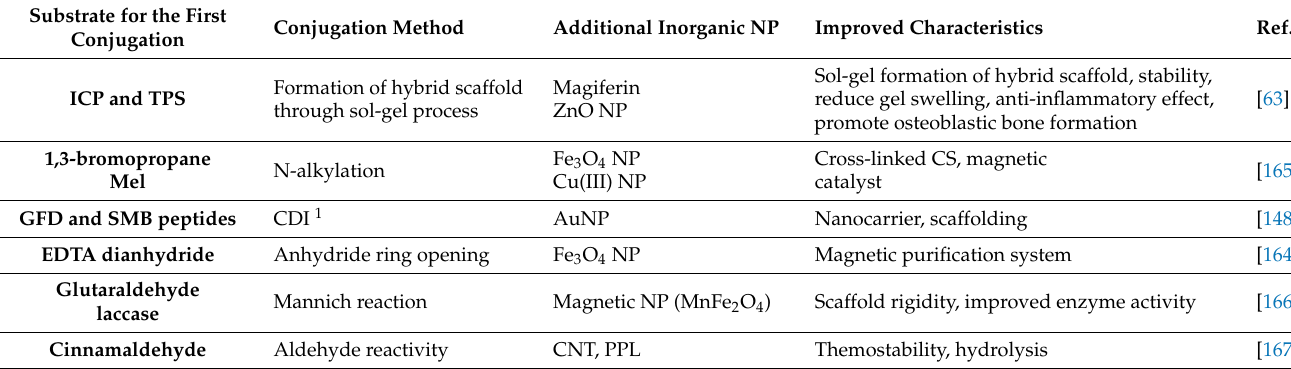
Table 5. Selected examples of CS-based conjugates combined with inorganic NPs.